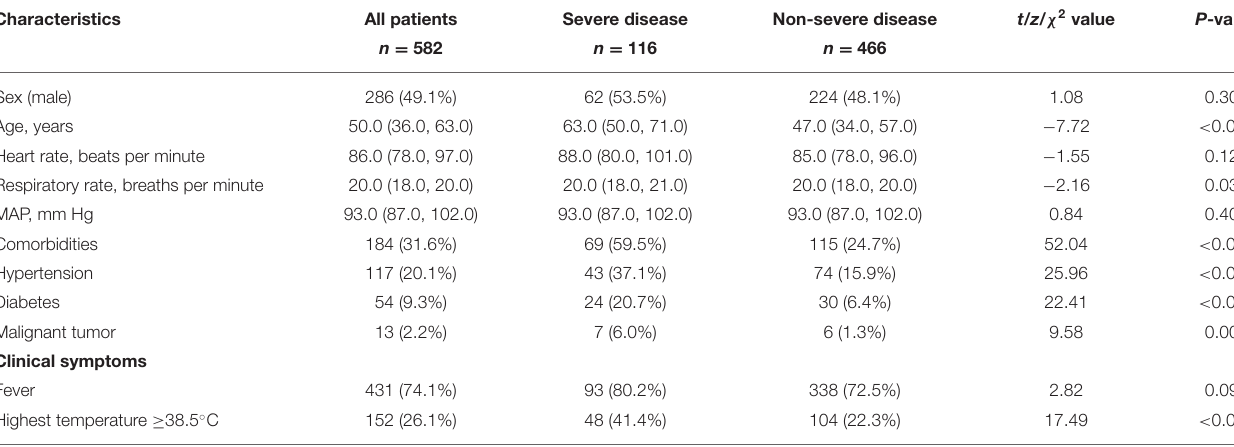
TABLE 1 | Baseline demographics and characteristics of the COVID-19